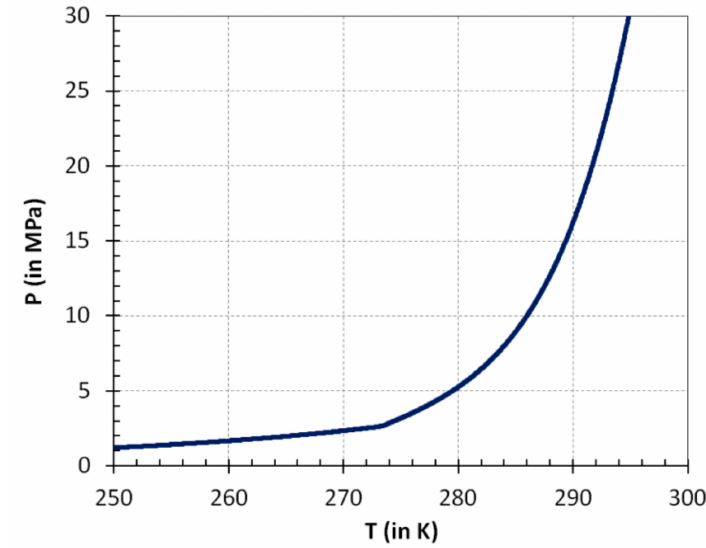
Figure 3. Pressure–temperature equilibrium relationship in the phase diagram of the water–ice– methane–hydrate system